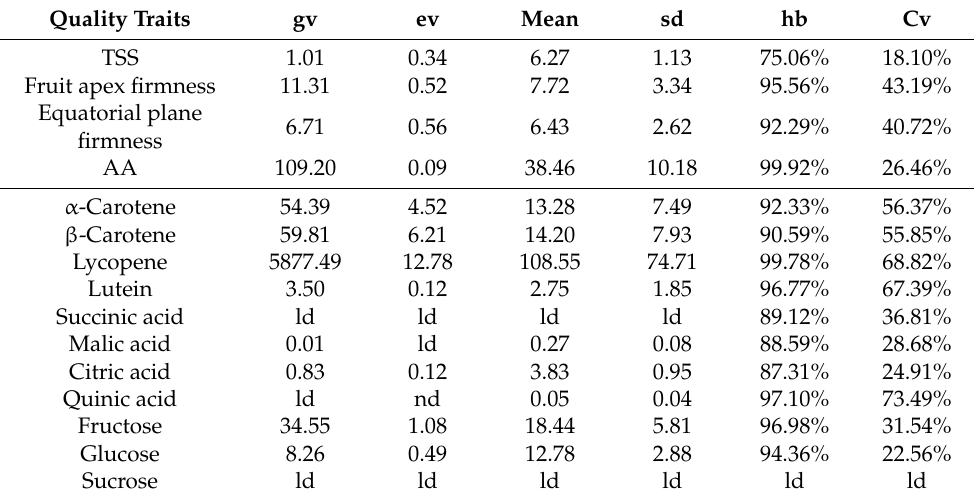
Table 2. Broad-sense heritability and the coefficient of variation of quality traits in tomatoes with different genetic